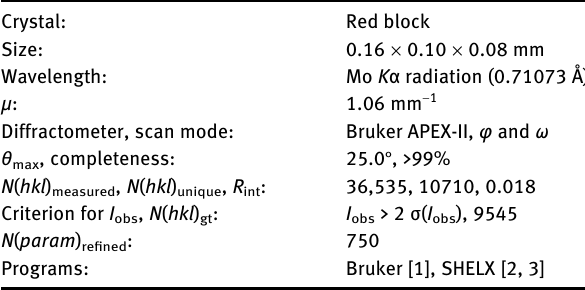
Table  : Data collection and